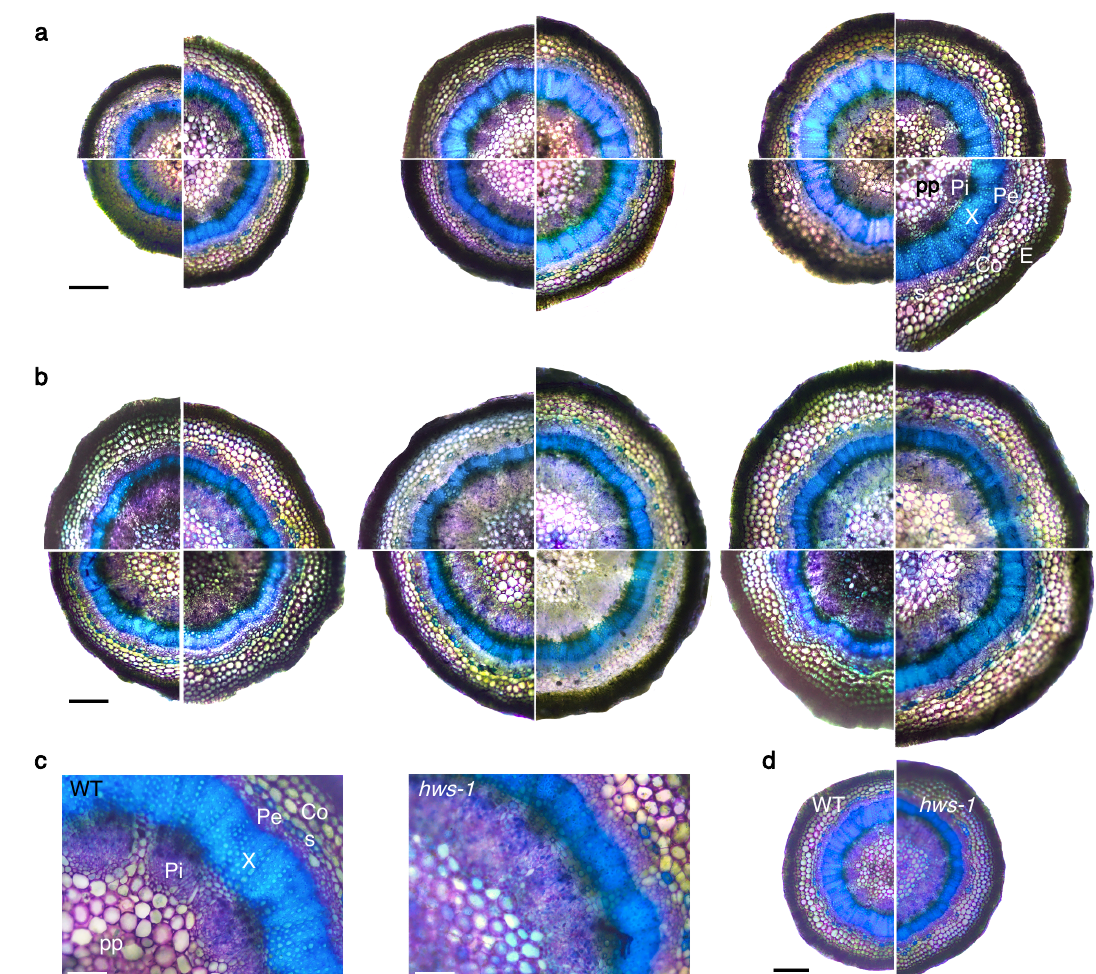
Figure 2. Transverse sections of representative pedicels showing wider phloem and narrower xylem rings in hws-1 . All sections were stained with toluidine blue prior to light microscopy observation. ( a ) Sections of WT pedicels. Each section is reconstructed from four segments of different pedicels. Segments are shown in a increasing diameter arrangement, clockwise from the bottom left segment. pp, pith parenchyma; Pi, internal phloem; X, xylem; Pe, external phloem; Co, collenchyma; s, sclerenchyma (blue-green stained); E, epidermis. Scale bar represents 250µm. ( b ) Sections of hws-1 pedicels, similarly to ( a ). ( c ) Details of selected WT and hws-1 pedicels with comparable diameters, showing vascular elements of strikingly different sizes. Scale bar represents 100µm. ( d ) Lower magnification of pedicels in c , shown for reference. Scale bar represents